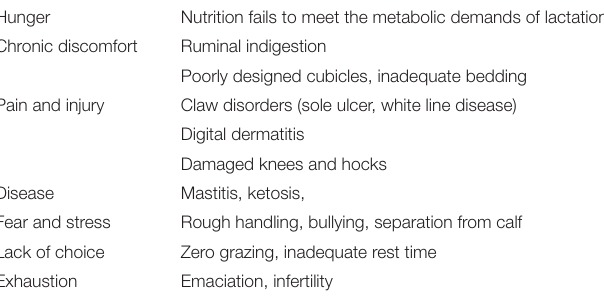
TABLE 5 | Abuses of the five freedoms that can arise through systematic failures in the provision of good husbandry. Hunger Nutrition fails to meet the metabolic demands of